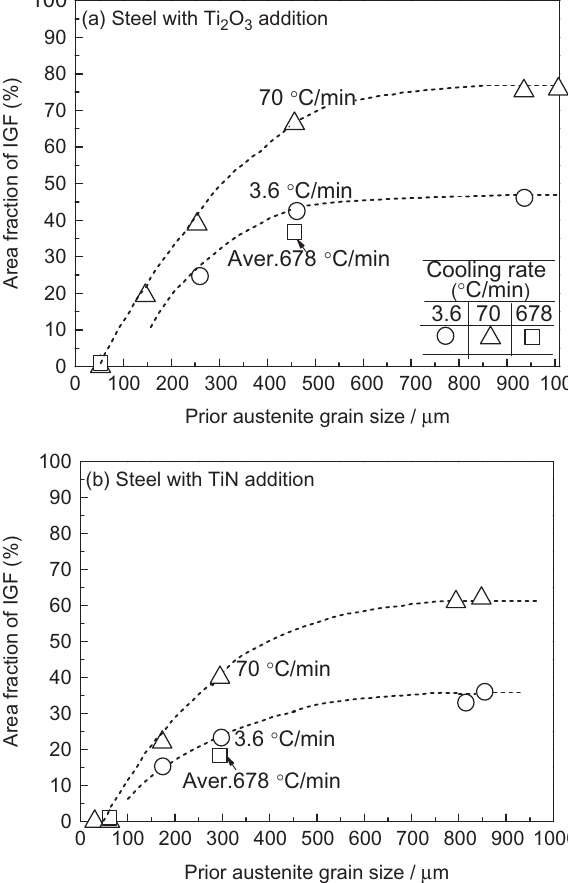
Figure 17: Relationship between the prior austenite grain size and the area fraction of IGF in (a) steel with Ti 2 O 3 addition and (b) steel with TiN addition